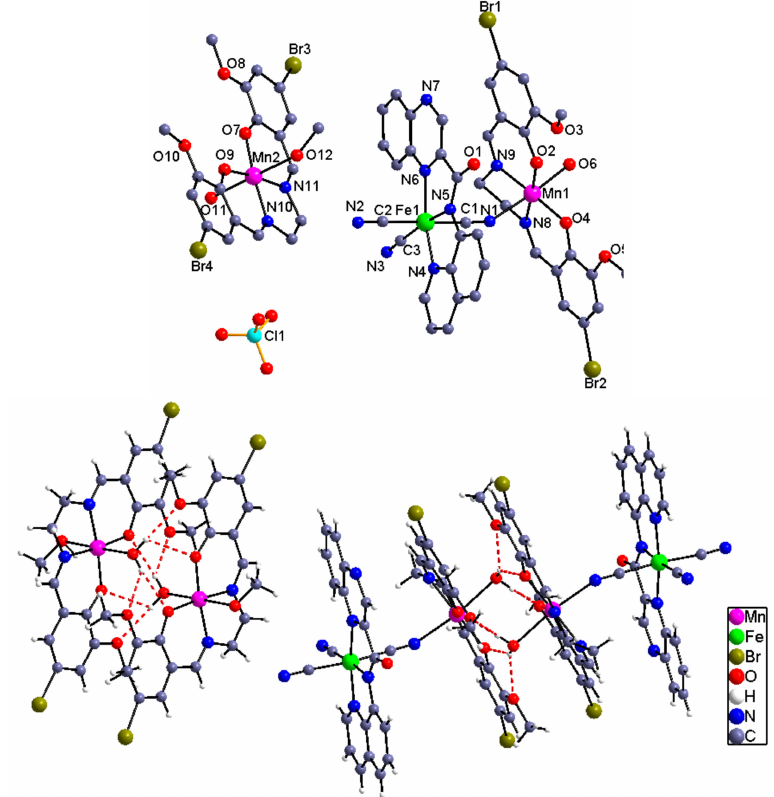
Figure 2. Molecular view of 2 with the selected atom label scheme and its H-bond interaction resulting supramolecular dimeric structure. The solvent contents have been omitted for clarity.